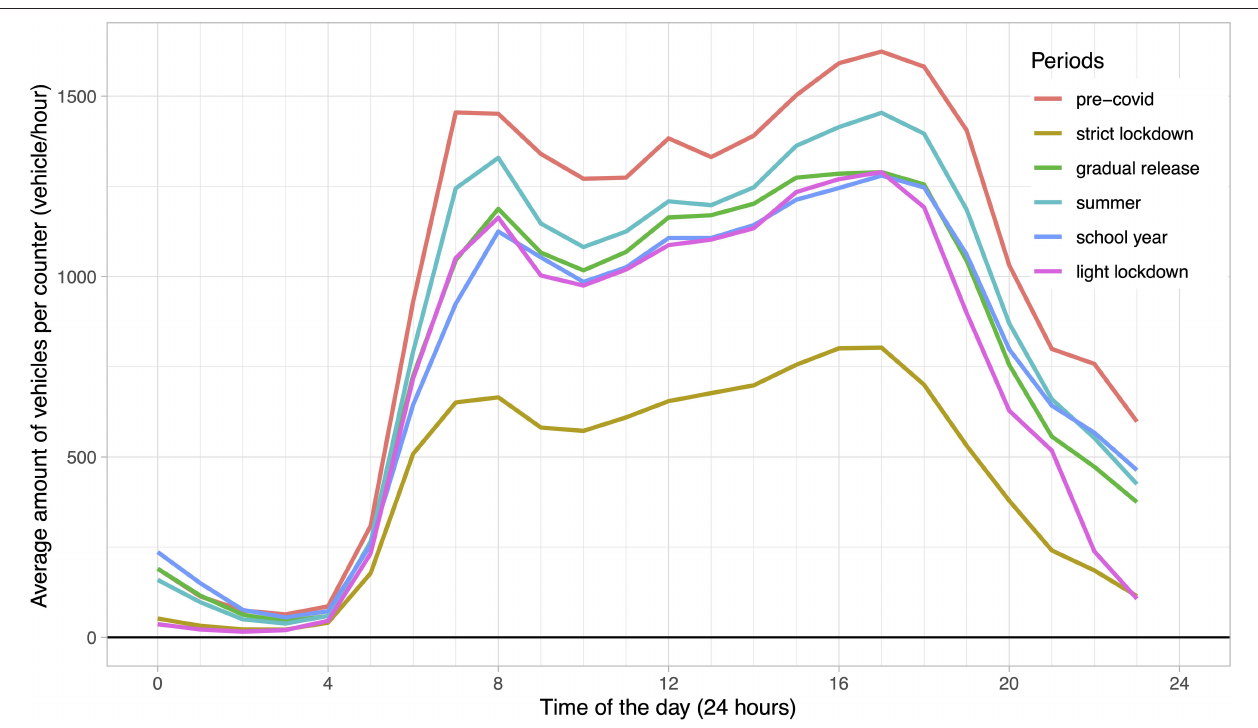
FIGURE 2 | Average road traffic levels per counter during the week and across the day for each of the six considered periods (data source: Brussels Mobility). Due to tunnel closing at night for maintenance, the extreme left and right of the graph are less